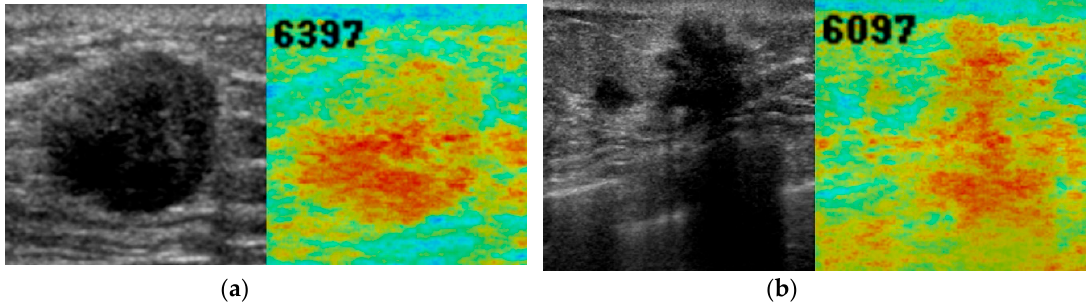
Figure 5. B-mode ultrasound images (left, grey) and anomaly score images (right, color) of breast with benign masses. A 46-year-old woman with intraductal papilloma ( a ) and a 58-year-old woman with fibroadenoma ( b ). There was abnormal red color consistent with the masses. The anomaly score was moderate medium to high (6020 and 4073, respectively).